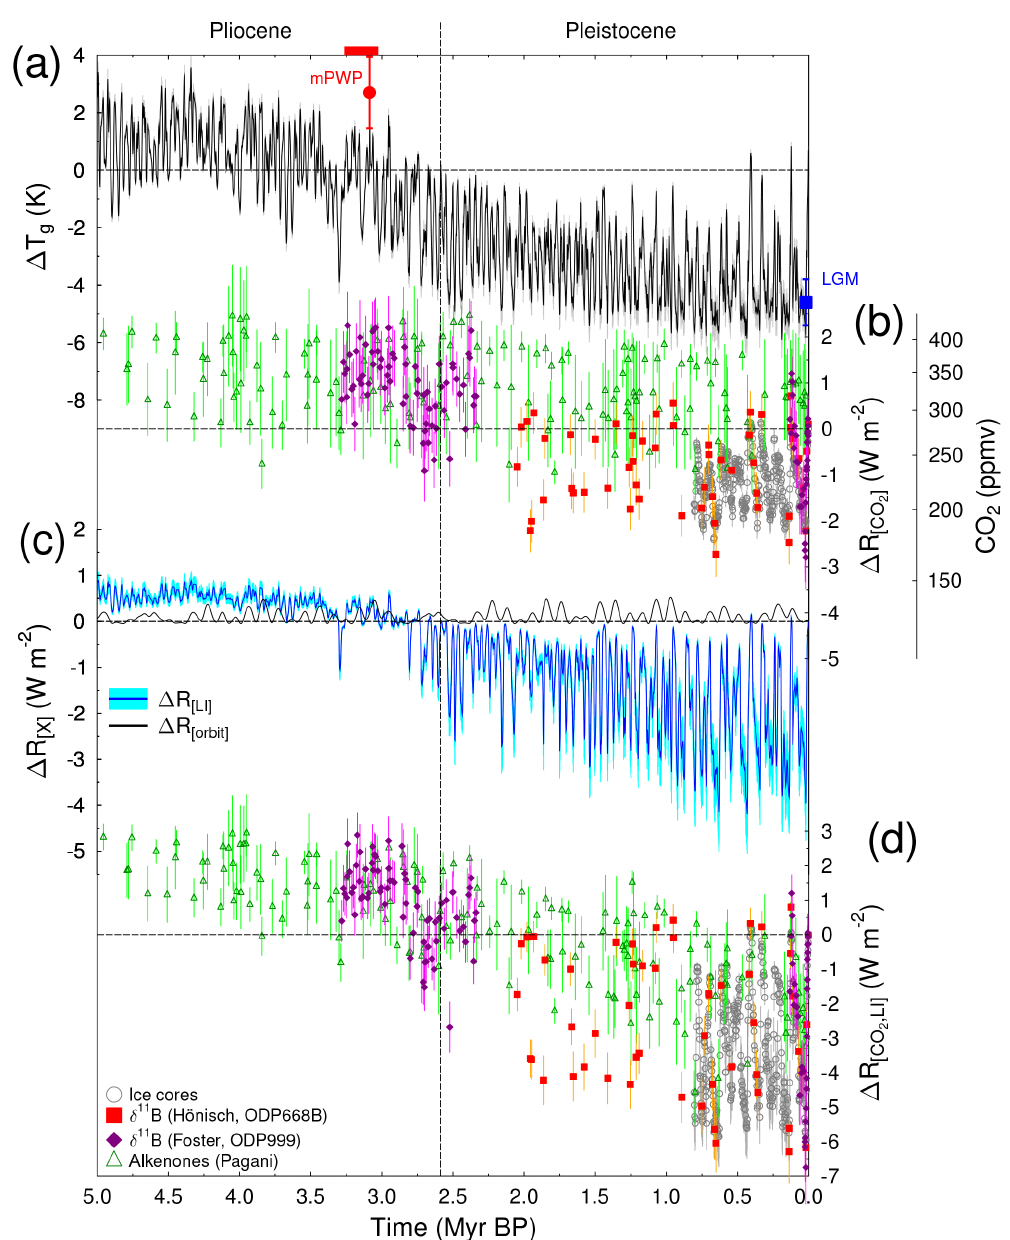
Figure 4. Changes in temperature and radiative forcing over the last 5Myr. Panel (a) : global mean surface temperature change, (cid:49)T g , calculated with the polar amplification factor, f pa , being a linear function of the Northern Hemisphere land temperature change, (cid:49)T NH . Marked are the mid-Pliocene warm period (mPWP) (red horizontal bar), global warming calculated within PlioMIP (red circle), and global cooling during the LGM derived from PMIP3 and CMIP5 (blue square). Panel (b) : changes in radiative forcing based on atmospheric CO 2 ( (cid:49)R [ CO ). CO 2 data are from ice cores (Bereiter et al., 2015) and based on δ 11 B (Hönisch lab (Hönisch et al., 2009), Foster lab (Foster, 2 ] 2008; Martínez-Botí et al., 2015)) and on alkenones (Pagani lab (Pagani et al., 2010; Zhang et al., 2013)). Panel (c) shows radiative forcing of land ice, (cid:49)R [LI] , and, for comparison, global annual mean insolation changes due to orbital variation, (cid:49)R [ orbit ] . Panel (d) : the sum of the radiative forcing changes due to CO 2 and land ice sheets ( (cid:49)R [ CO ) whenever CO 2 data allow its calculation. Uncertainties show 1 σ 2 ,LI ]